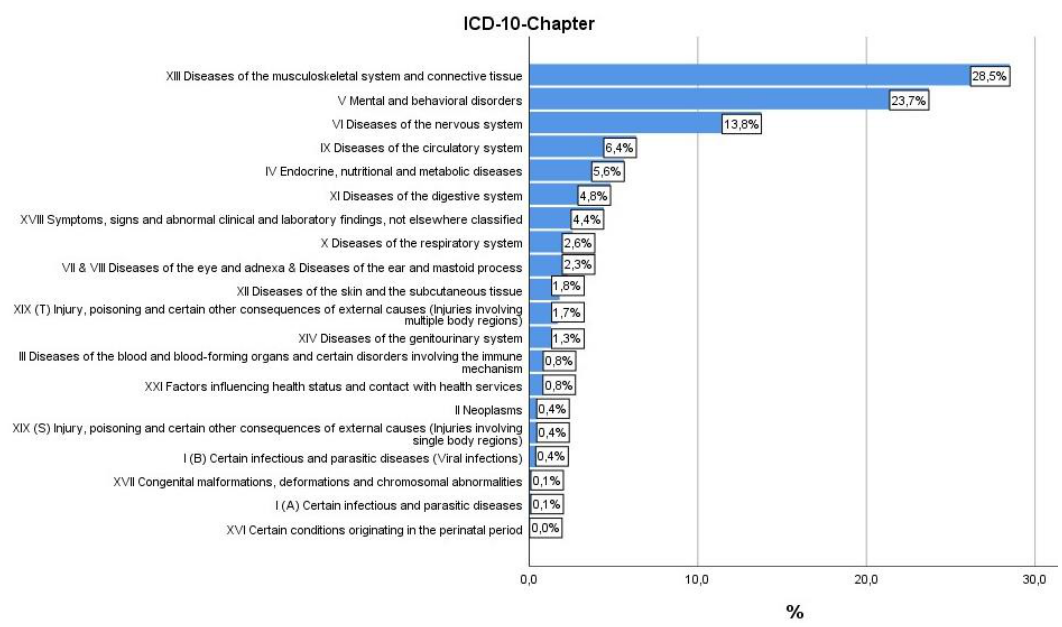
Figure 2. ICD-10 diagnosis of patients at discharge.